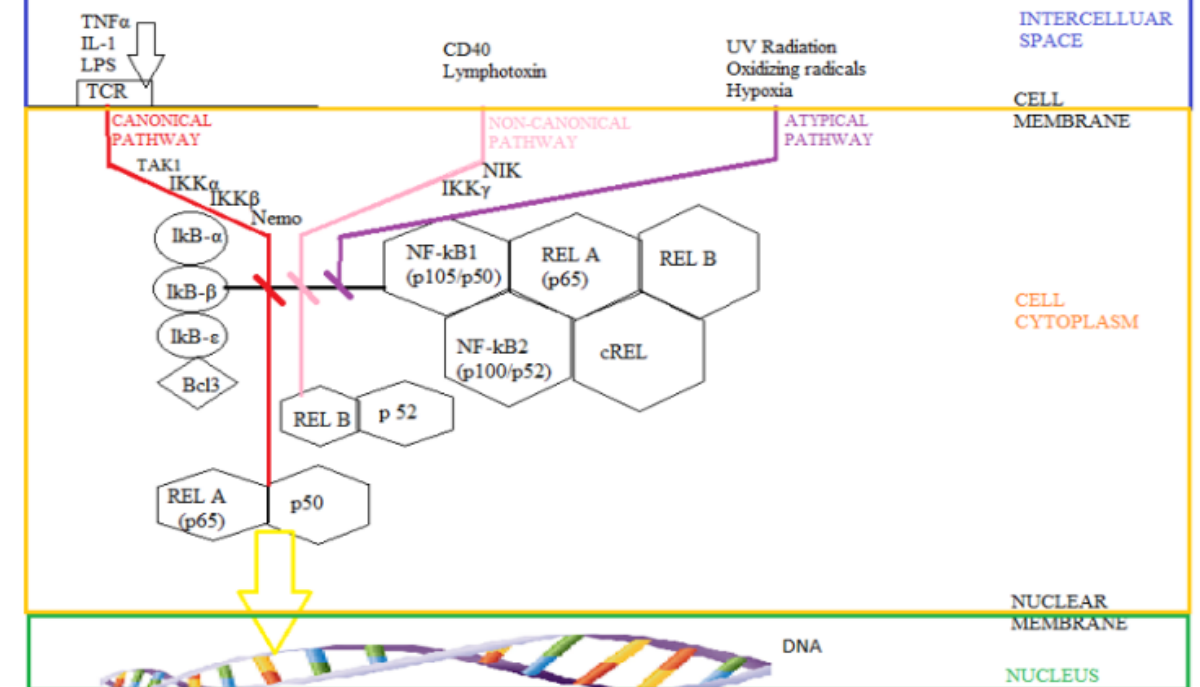
Figure 4. The Nuclear Factor kB (NF- kB) pathways activation: the canonical pathway (triggered by Figure 3. The Nuclear Factor kB (NF-kB) pathways activation: the canonical pathway (triggered by the action of tumor necrosis α, TNFα; int erleukin 1, IL-1, and lipopolysaccharides, LPS, on T cell the action of tumor necrosis α , TNF α ; interleukin 1, IL-1, and lipopolysaccharides, LPS, on T receptor, TCR, with involvement of transforming growth factor activating kinase—B, TAK1; the kB inhibitor complex kinase α, β, IKK α, β; of the essential modulator of NF -kB, IkB- α, β, ε kB inhibitor family, Nemo), the non -canonical pathway (involving NF- κB -induced kinase, NIK, and IKK γ) and the atypical pathway.